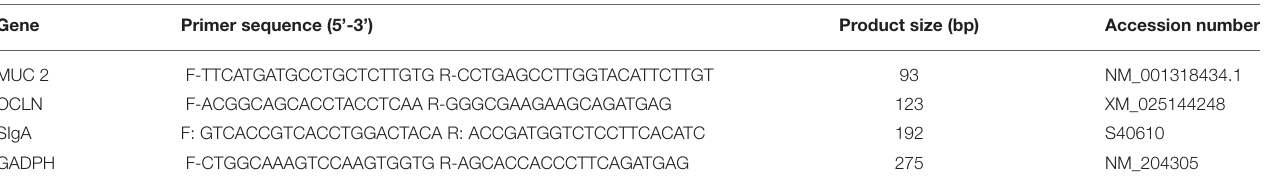
TABLE 4 | The sequence of target primers and housekeeping